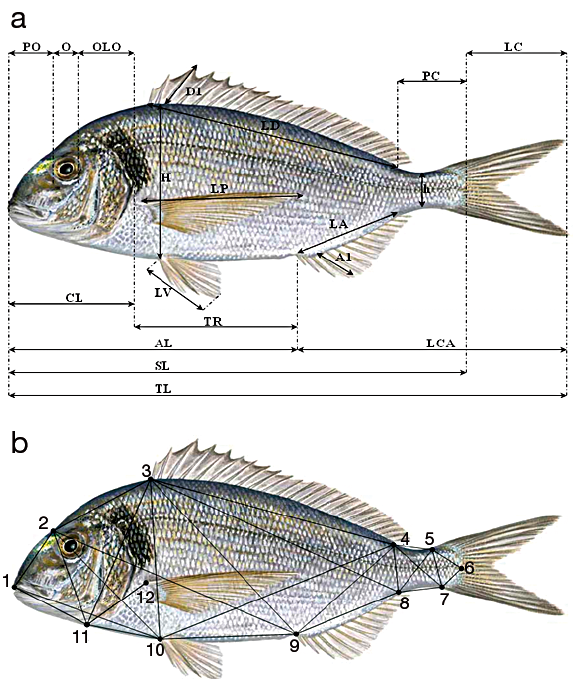
Fig. 2. Schematic drawing of gilthead sea bream ( Sparus au- rata ) body with measured distances and landmarks. (a) Tra- ditional set of measurements (Hubbs & Lagler 1947) and (b) vectors according to the truss network system (Bookstein 1982). See Table 1 for